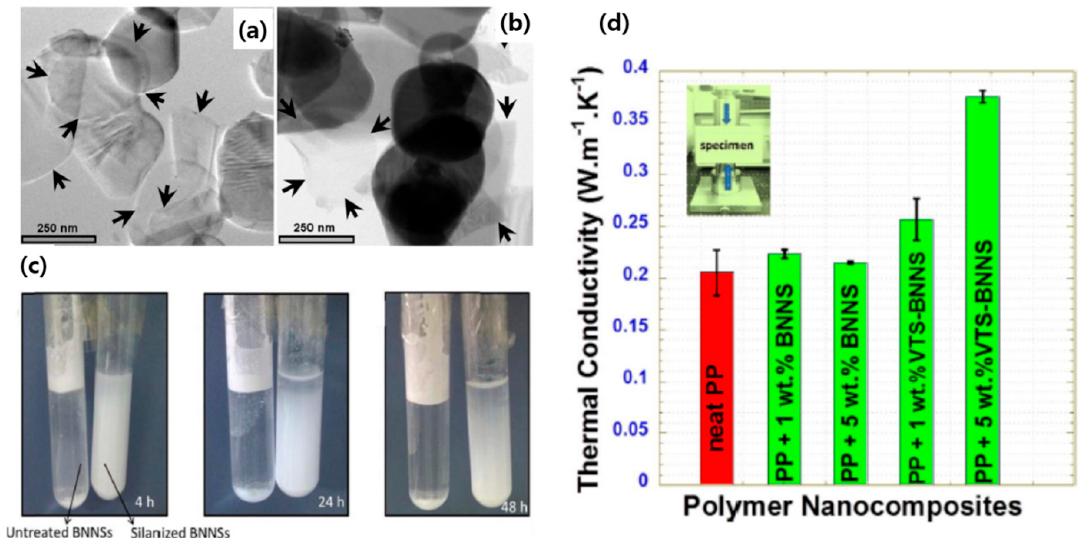
Figure 4. ( a , b ) TEM image of hexagonal boron nitride nanosheets (BNNSs) produced